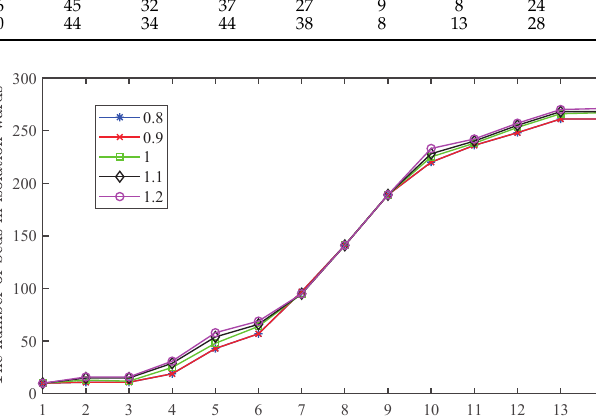
Figure 14. The number of beds in isolation wards in case 3.